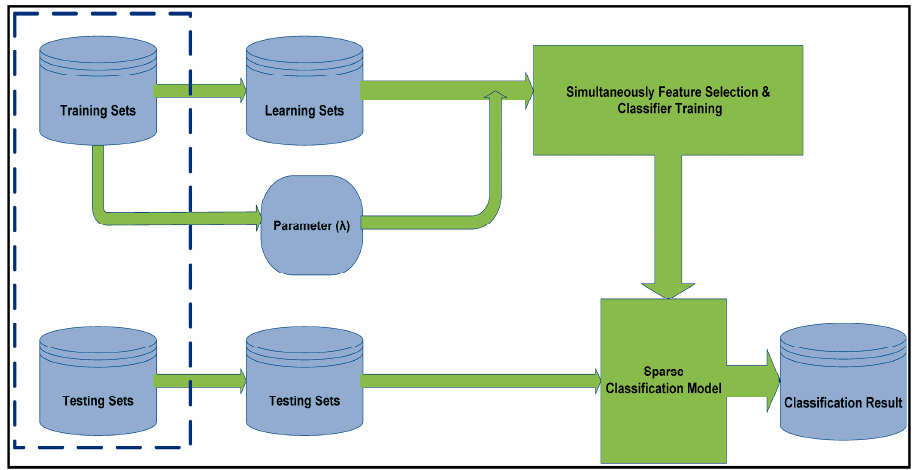
Figure 4. A taxonomy of SPLR for the IDS.